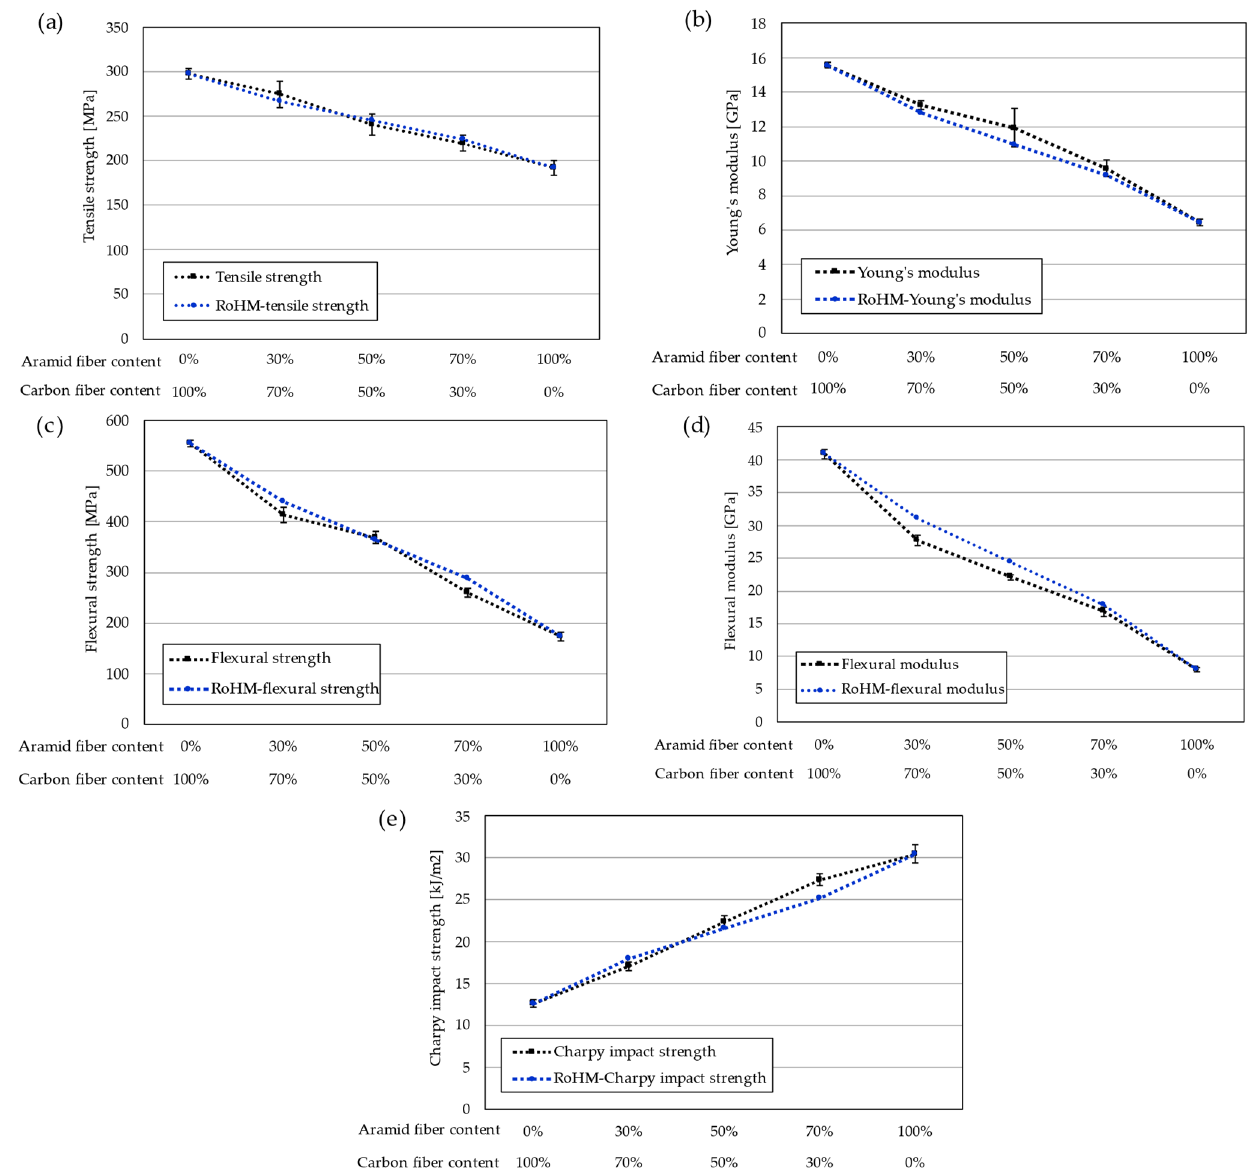
Figure 8. Comparison between experimental and predicted RoHM values: ( a ) tensile strength; ( b ) Young’s modulus; ( c ) flexural strength; ( d ) flexural modulus; ( e ) Charpy impact strength. For the Charpy impact strengths, especially with increasing aramid content, positive hybrid effects of +4.0% for 50CF/50AF and +9.0% for 30CF/70AF were shown while a neg- ative hybrid effect of − 5.2% was observed at low aramid content of 30%. The negative